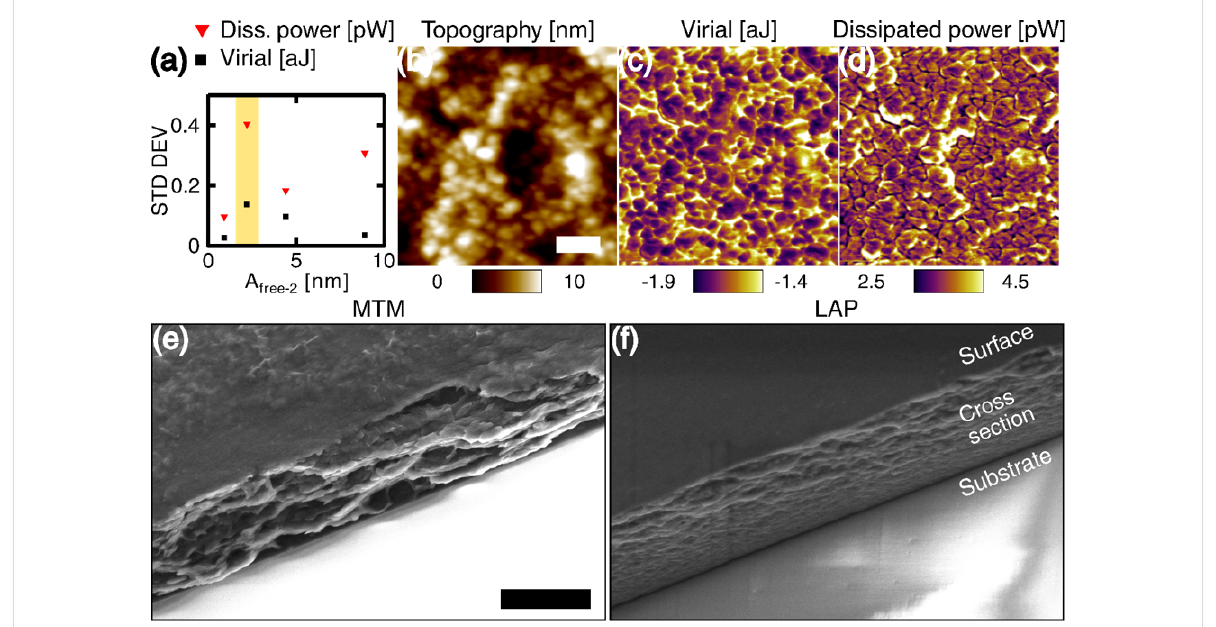
Figure 4: Measurement of virial and dissipated power for the second eigenmode of the cantilever in bimodal AFM, on the nanocomposite surface for 33/67 ratio of thin Laponite-RD/PEDOT:PSS. The first eigenmode was operated in repulsive regime (phase below 90°). The amplitude of the second eigenmode was varied in order to optimize the contrast in the energy quantities as described in [63] and summarized in (a), where the standard devia- tion of the measurement is plotted against the free oscillation amplitude. Images (b–d, topography, virial and dissipated power) correspond to the condition highlighted by the yellow area in (a). The scale bar (b) is 100 nm. (e–f) SEM characterization of the sample cross section. The scale bar in (e) is 5 μ